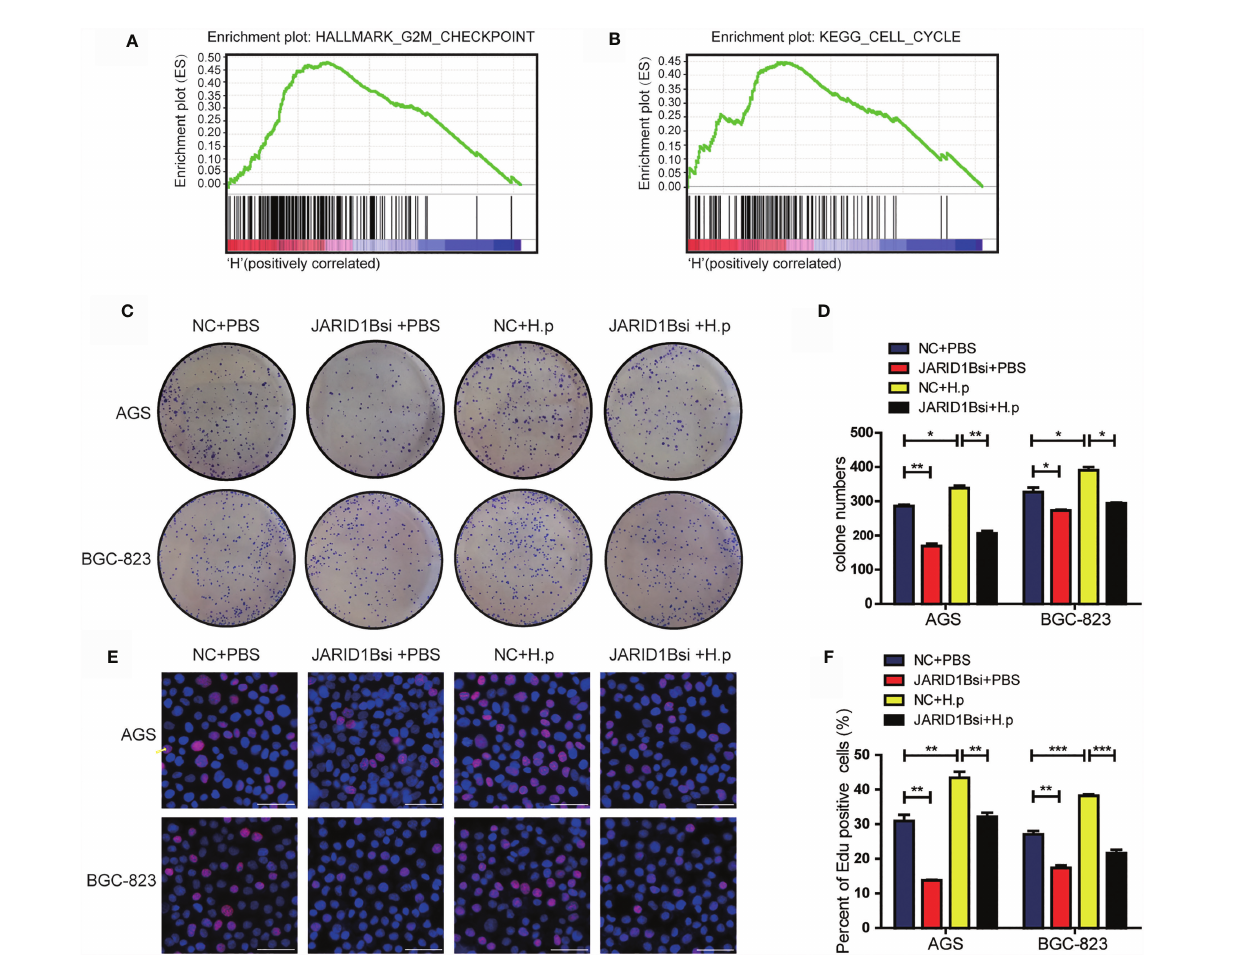
FIGURE 6 | H. pylori promotes the proliferation of gastric cancer (GC) cells via JARID1B. (A, B) Enrichment plots from gene set enrichment analysis (GSEA). (C, D) Cloning formation test including the control group, JARID1B siRNA group, H. pylori infection group, and JARID1B siRNA combined with H. pylori infection group in AGS and BGC-823 cells, representative picture (C) and quantitative map (D) . (E, F) EdU assay including the control group, JARID1B siRNA group, H. pylori infection group, and JARID1B siRNA combined with H. pylori infection group in AGS and BGC-823, representative picture (E) and quanti fi ed map (F) . All results were repeated three times, and each horizontal line in the quanti fi ed graph of the fi gure represents the mean ± standard error of three experiments. Scale bar, 50 m m. *P < 0.05; **P < 0.01; ***P < 0.001 (Student ’ s ( Figure 7B ). The analysis of 45 pairs of GC and corresponding adjacent normal tissues in the GSE63089 also revealed a signi fi cant positive correlation between JARID1B and CCND1 ( Figure 7C ). Furthermore, the expression levels of JARID1B and several proliferation-associated genes including cyclins (CCND1,